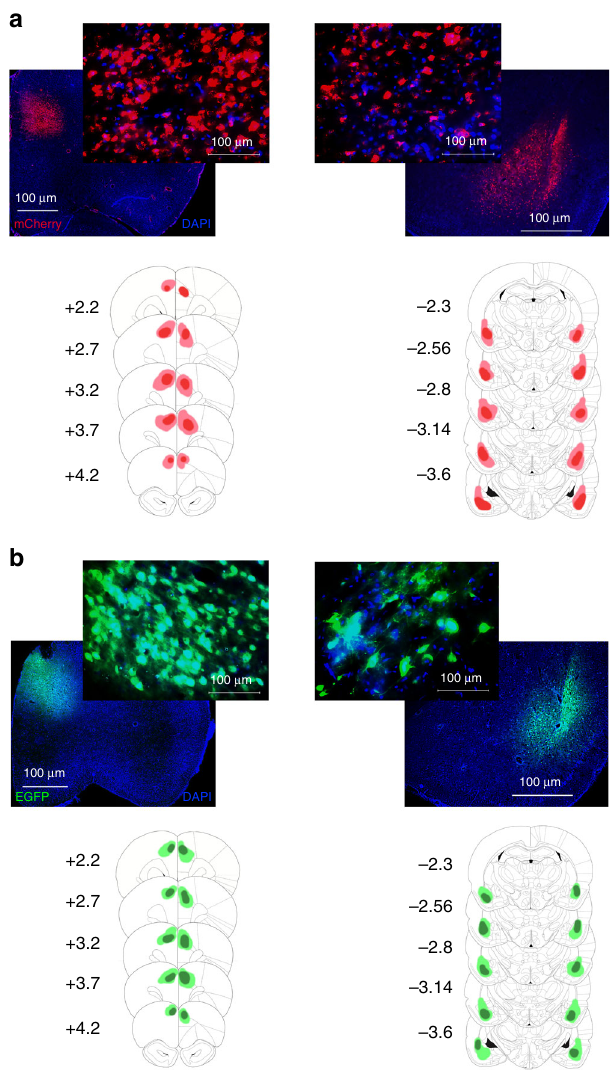
Fig. 3 Expression of inhibitory DREADDs and null virus EGFP in anterior cingulate cortex and basolateral amygdala. a Top, representative expression of hM4Di-mCherry DREADDs under CaMKIIa is shown for ACC (left) and BLA (right). Bottom, reconstructions of maximum viral spread for all rats. Numerals depict + anterior – posterior (AP) level relative to Bregma. Scale bars 1000with 100 μ m (inset). b Top, representative expression of eGFP (null virus) under CaMKIIa is shown for ACC (left) and BLA (right). Bottom, reconstructions of maximum viral spread for all rats. Numerals depict + anterior – posterior (AP) level relative to Bregma. Scale bars 1000 with 100 μ m (inset). Source data are provided as a Source Data fi